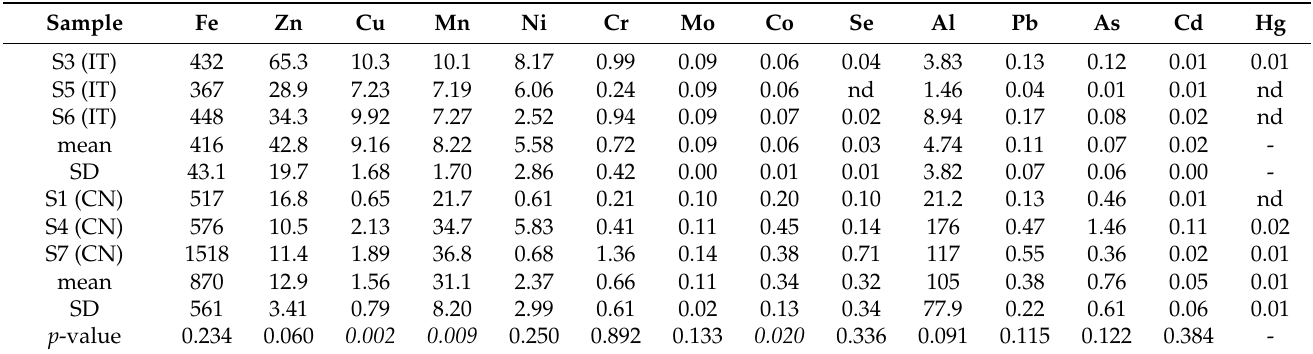
Table 2. Trace element content in six selected commercial samples. Samples S1, S4, and S7 were produced in China (CN), while samples S3, S5, and S6 were produced Italy (IT). Data are expressed as µ g g − 1 dw. The p -value for comparison between Italian and Chinese samples is reported; a p -value < 0.05 was considered